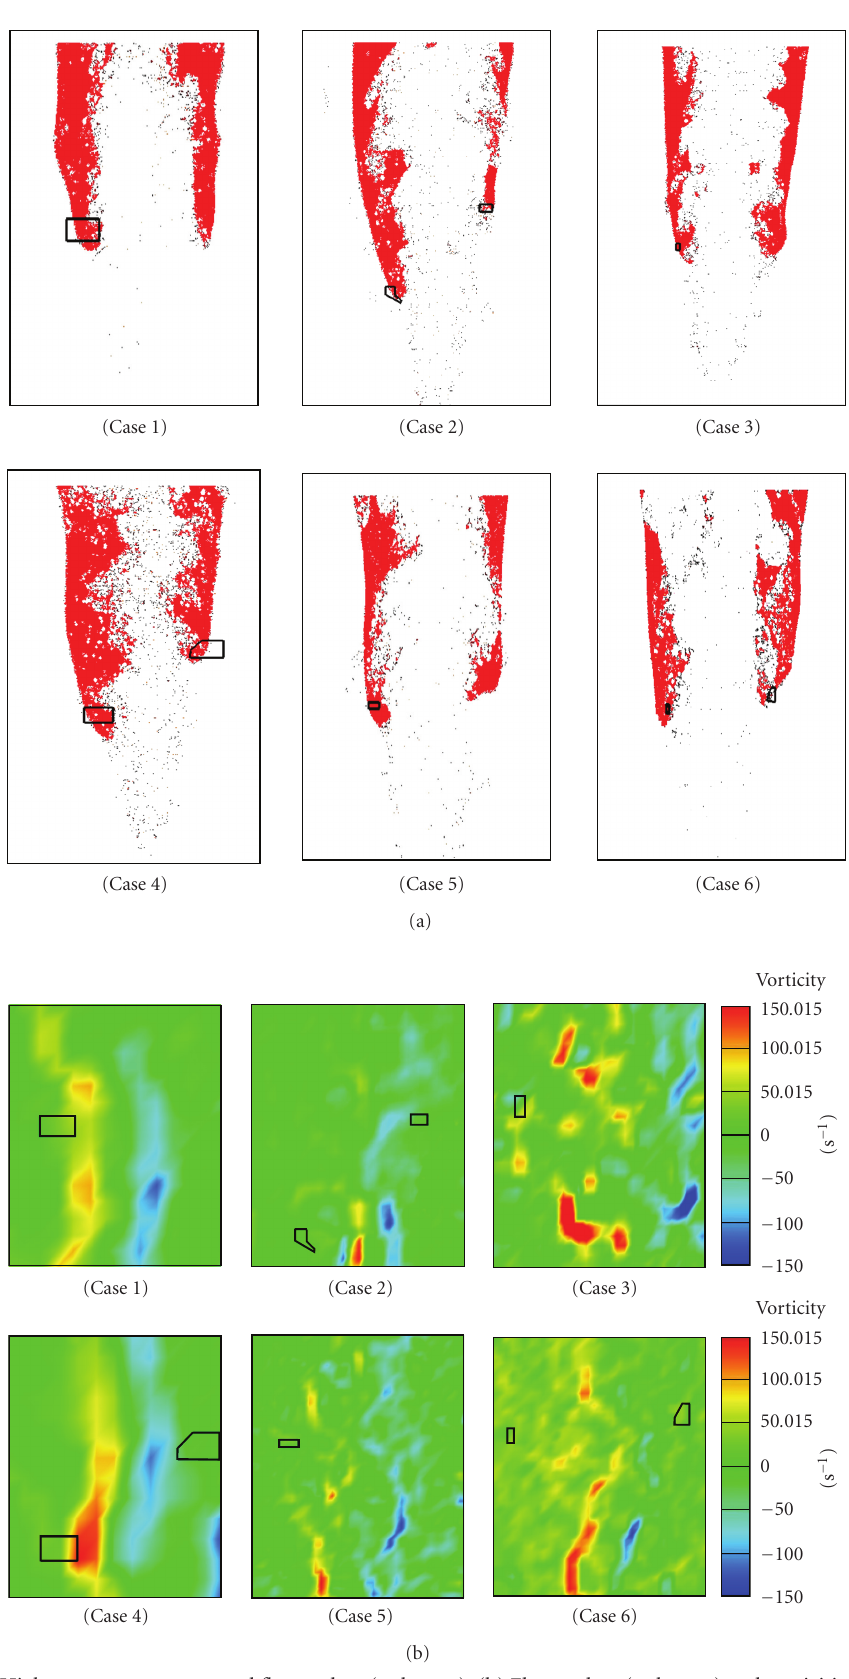
Figure 3: (a) High temperature zones and flame edges (polygons). (b) Flame edges (polygons) and vorticities